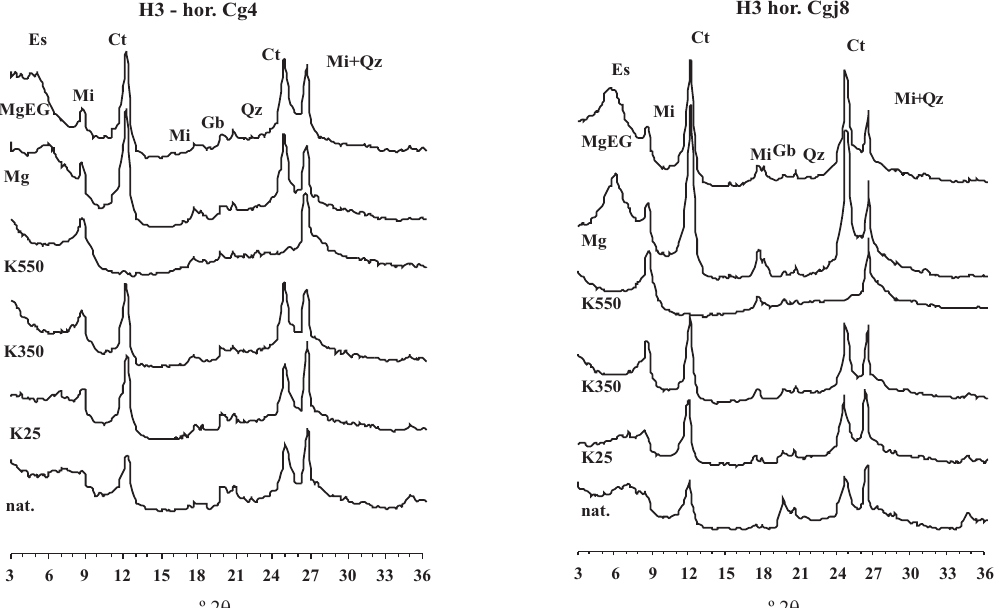
Figura 3. Difratogramas da fração argila dos horizontes Cg4 e Cgj8 do perfil H3. Ct: caulinita, Mi: mica, Qz: quartzo, Gb: gibbsita, Es: